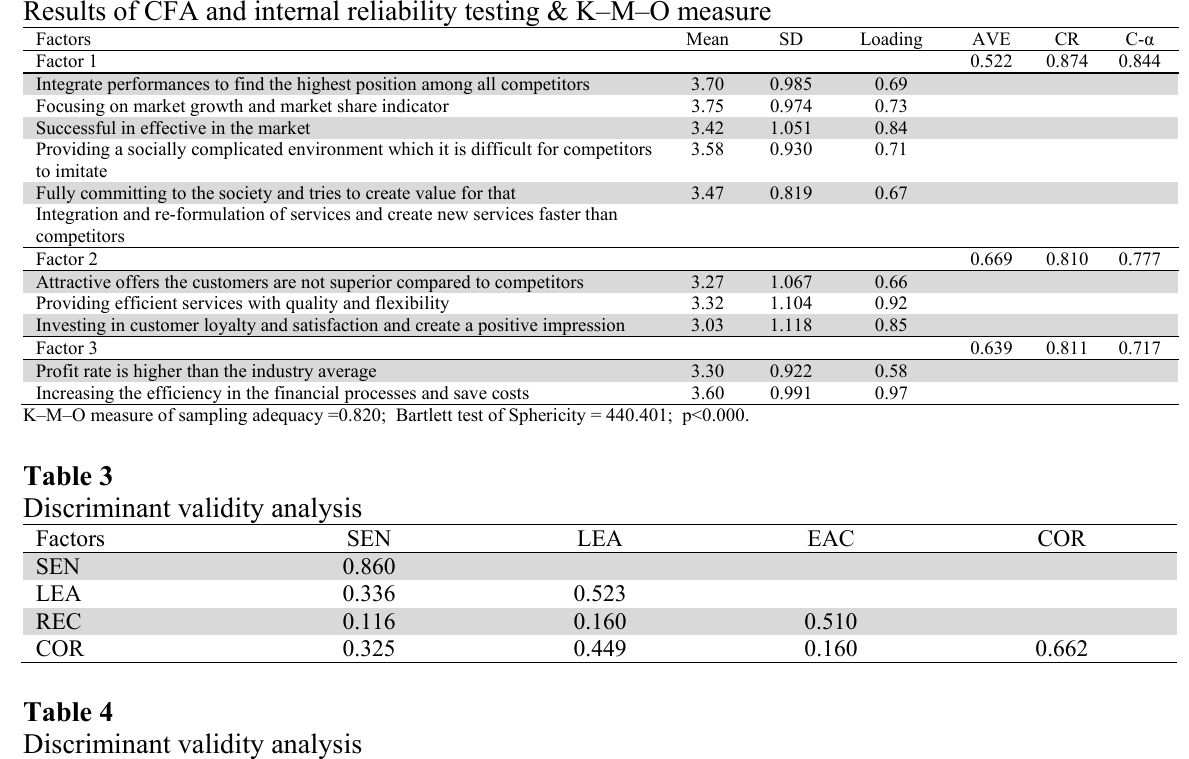
Discriminant validity analysis